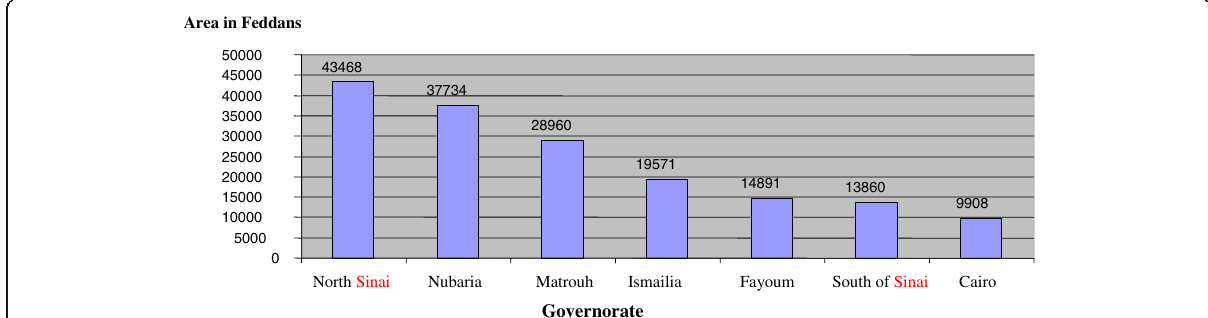
Fig. 1 Governorates and regions according to the cultivated area of olive in 2012. Source: Abstract of the Agricultural Economy Bulletin, Table (96), Central Administration of Agricultural Economics, Economic Affairs Sector, Ministry of Agriculture and Land Reclamation, Giza, 2013, p. 332